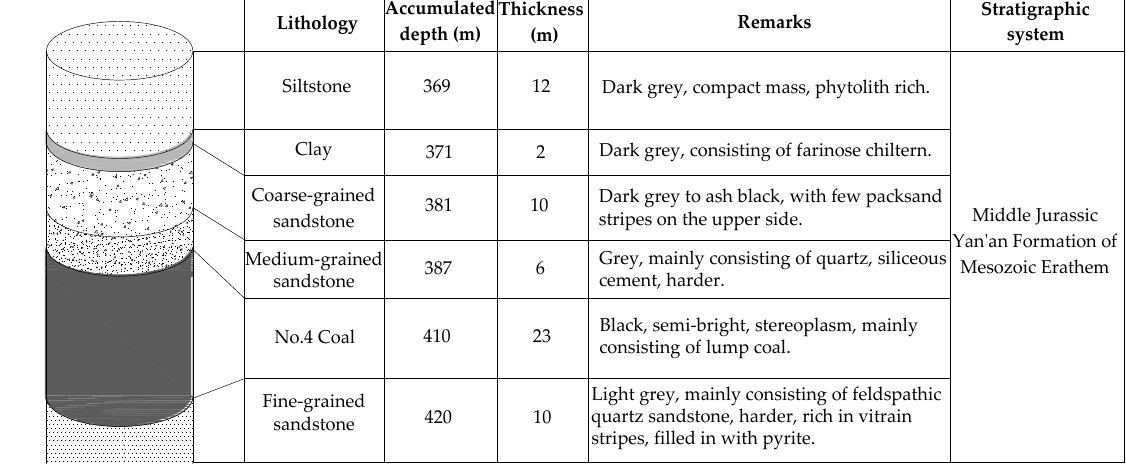
Table 3. Mechanical parameters of coal and rock layers.